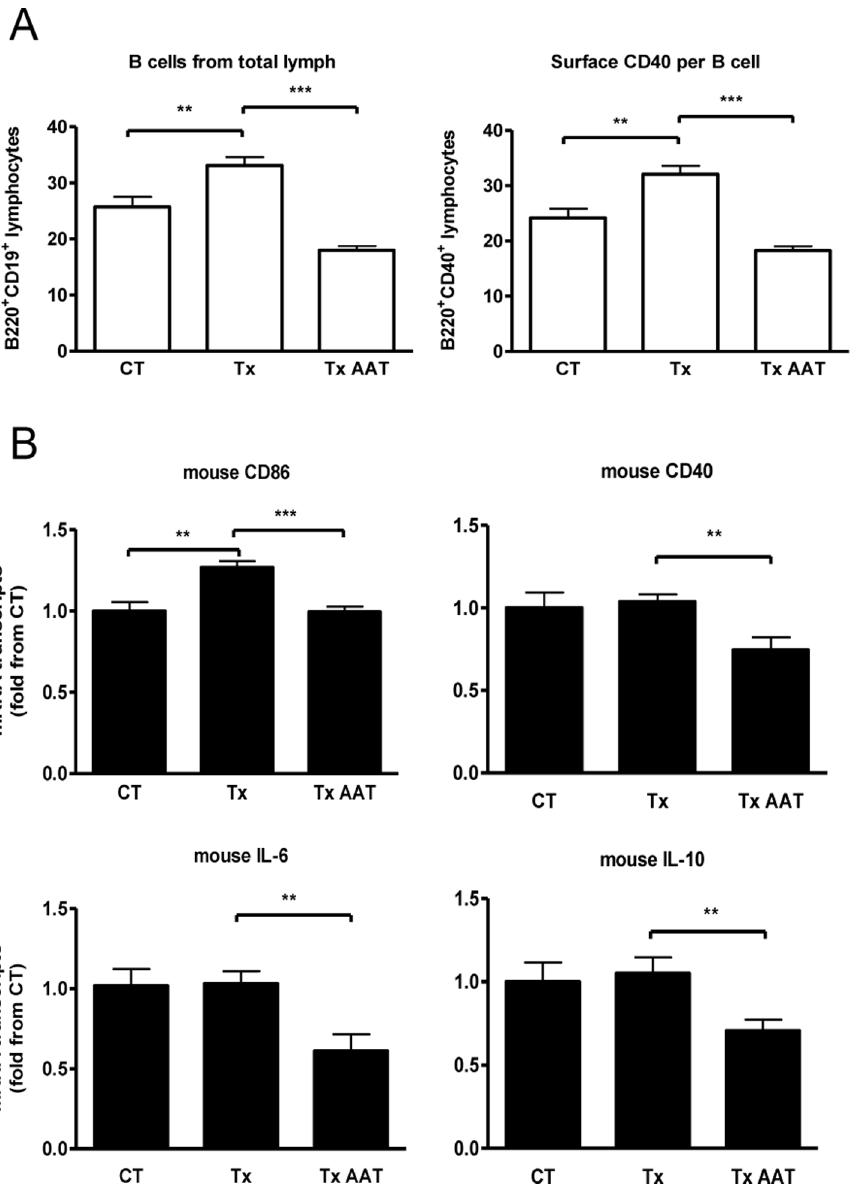
Figure 2. DLN response to human AAT monotherapy after skin xenografting. Mice were either SHAM operated (CT) or recipients of rat skin (Tx) in the absence or presence of human AAT monotherapy. ( A ) 14-day DLN. FACS analysis. Results expressed as fold change from CT, mean 6 SEM from n=10/group; **p , 0.01, ***p , 0.001. ( B ) 72-h DLN. RT-PCR. Results expressed as fold change from CT, mean 6 SEM from n =3/group; **p , 0.01, ***p ,